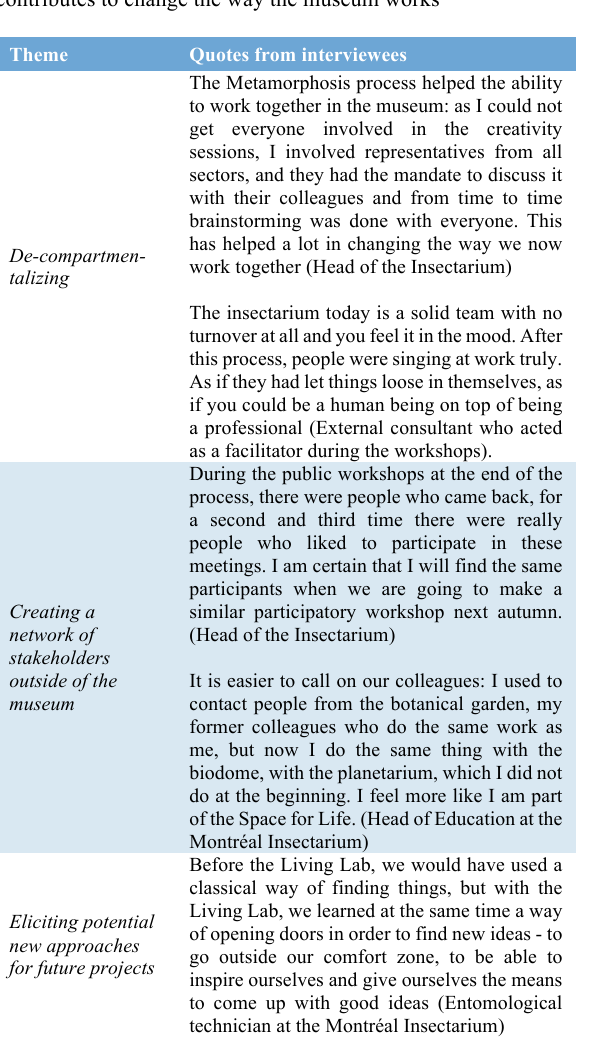
Table 2. How experimenting with collaborative processes contributes to change the way the museum works